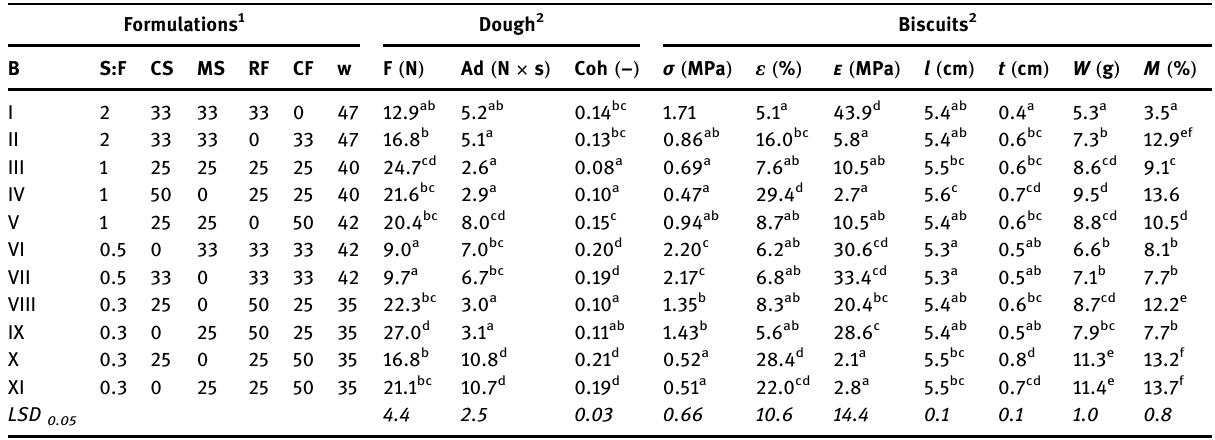
Table 3: Dough ( TPA ) and biscuit ( Three - point bending test ) texture of gluten - free formulations Formulations